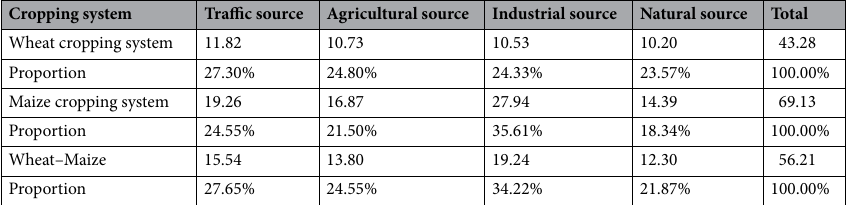
Table 3. Ecological risks from soil heavy metals in wheat and maize cropping systems.